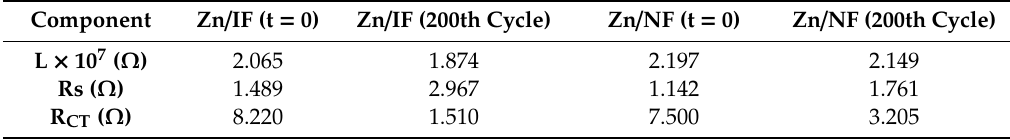
Table 3. Resistance values of Zn anodes in the electrolyte at initial state (t = 0) and after the 200th charge–discharge cycle.